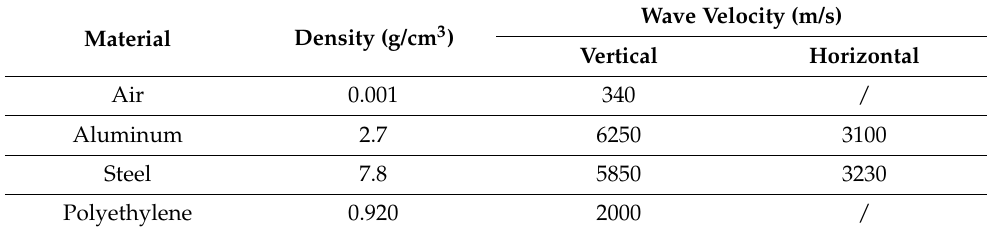
Table 1. Wave velocity of several common materials. Acoustic velocity meters of common materials measure longitudinal acoustic velocity, so we only calculate the longitudinal acoustic data (“Vertical” in Table 1).